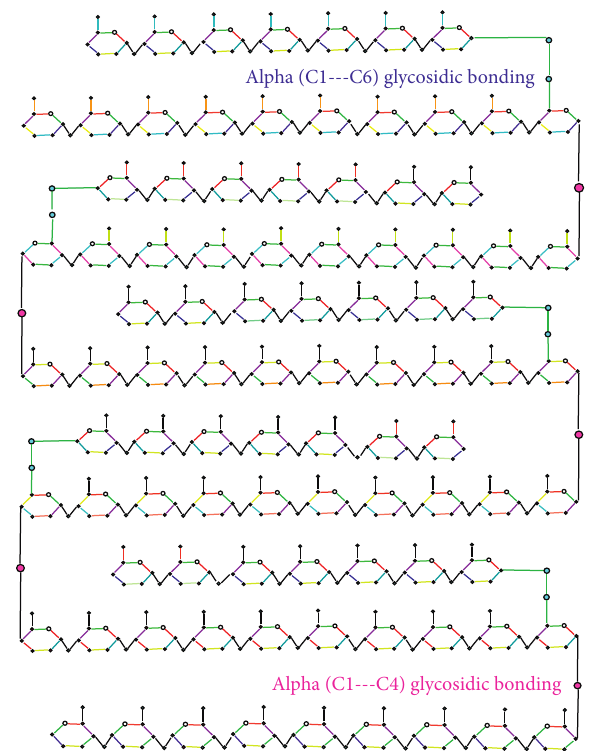
Figure 6: Hydrogen-depleted molecular graph of glycogen network GL 7